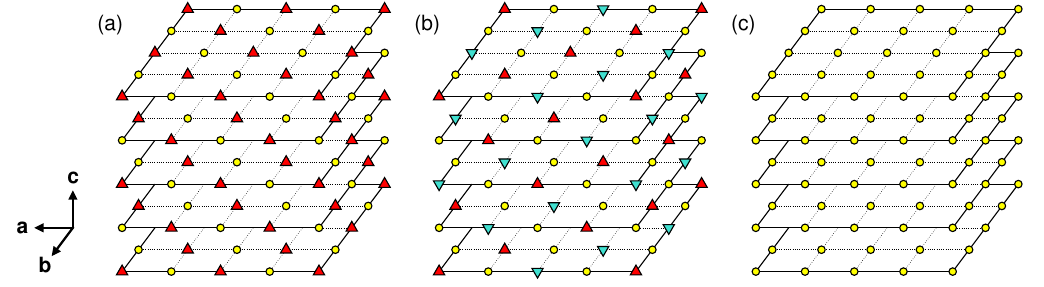
Figure 7: Magnetic configurations of (a) FM, (b) AFM, and (c) PM, which are an- alyzed within the DFT approach. Here, the spin states are indicated for HS ↑ (red triangle-up), HS ↓ (blue triangle-down), and LS (yellow circle).